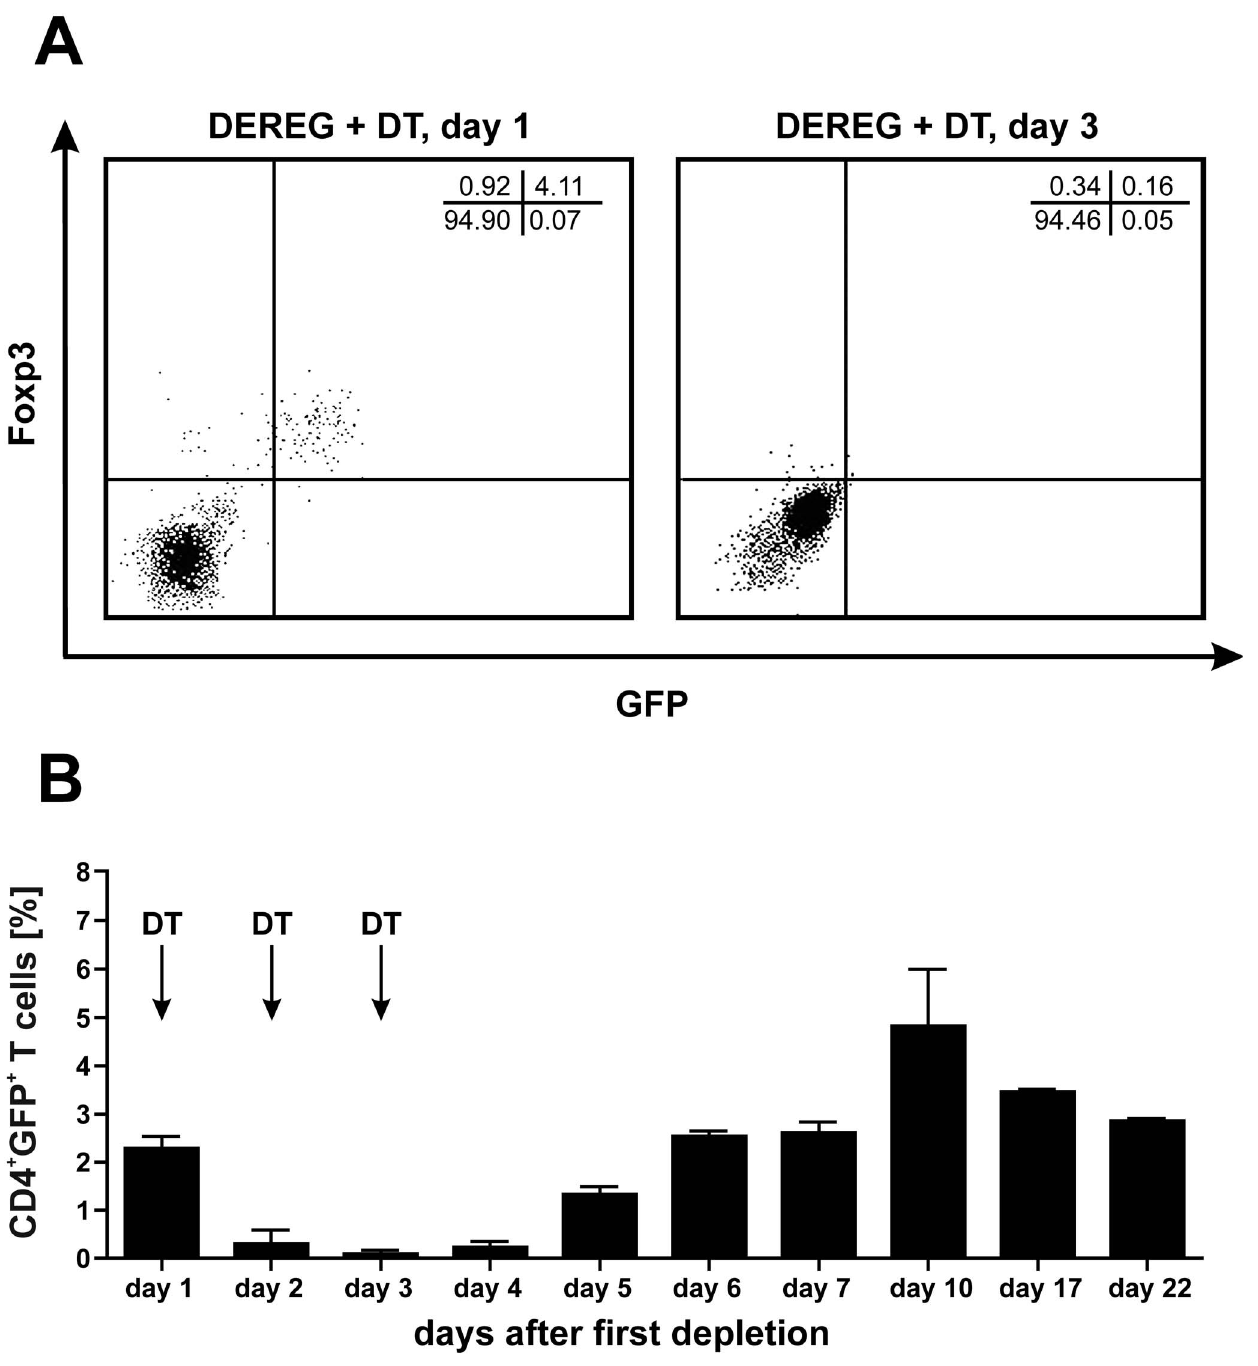
Figure 1. Kinetics of T reg depletion in DEREG mice. In DEREG mice on BALB/c background Foxp3 + T reg can be indentified by their eGFP expression using flow cytometry. The consecutive application of DT i.p. over three days leads to a depletion of eGFP + Foxp3 + T reg within 72 h (A). For immunization experiments we used an optimized protocol where mice were treated with DT on days + 1, + 2 and + 3. The percentage of CD4 + GFP + T reg in the blood was measured in two F1 DEREG C57BL/6 x BALB/c mice by flow cytometry at the indicated time points (B). Data is expressed as mean + / 2 SEM in relation to all cells in the lymphocyte gate as defined by the respective forward- and sideward scatter.